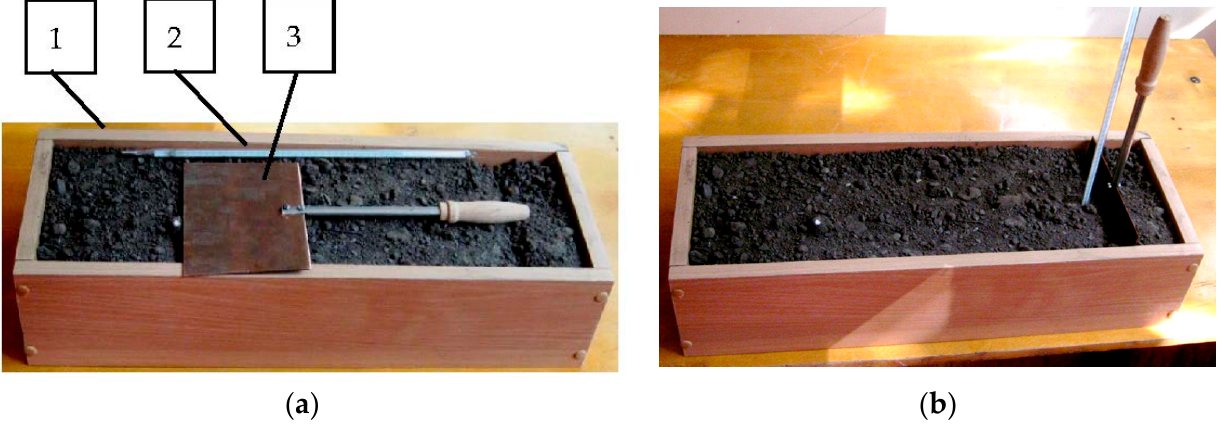
Figure 1. Complete set of equipment for measuring thermal diffusivity of soil ( a ) and arrangement of this equipment during measurements ( b ): 1—box with soil; 2—thermometer; 3—copper plate.